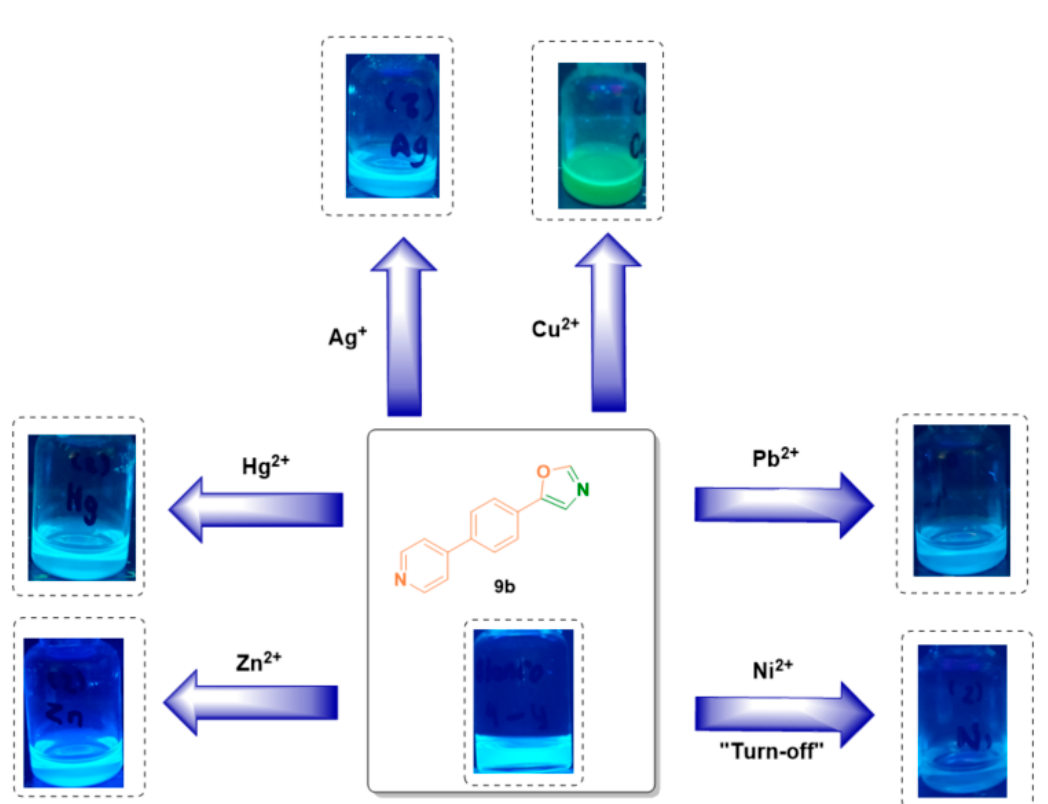
Figure 2. Fluorescence changes studies by naked-eye of oxazole 9b of various cations.